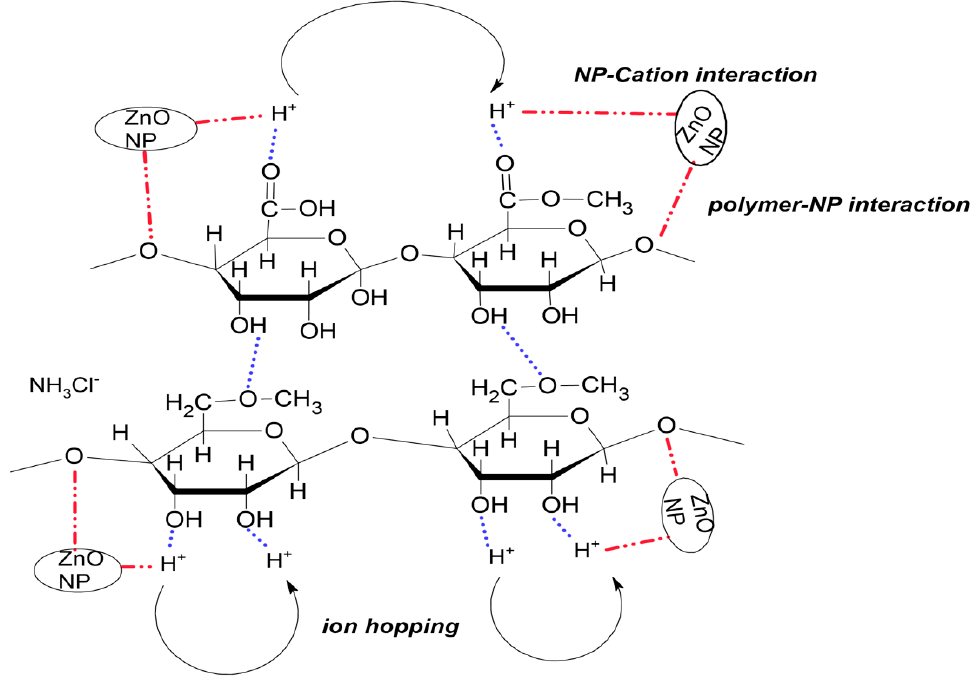
Figure 3. Probable interaction scheme of NH 4 Cl salt and ZnO nanofiller with MC/PC based polymer blend.